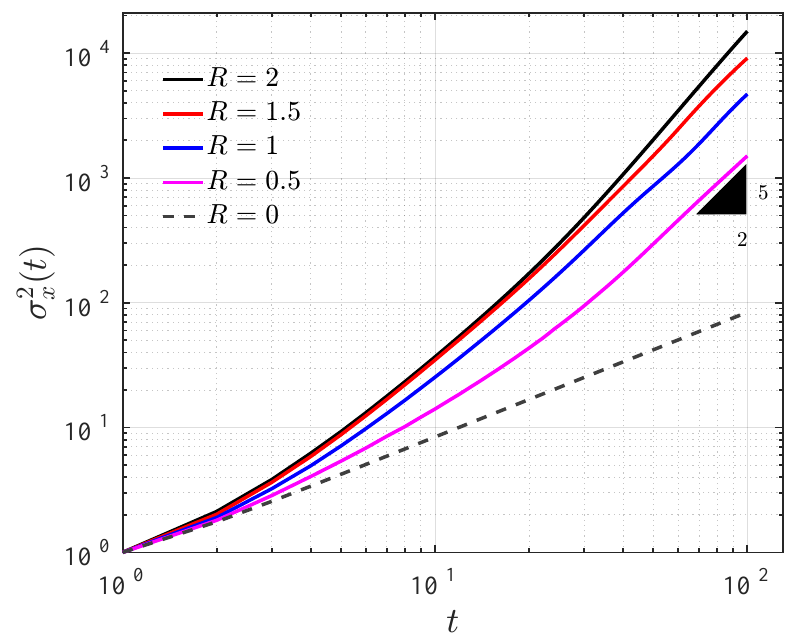
Figure 5. Temporal evolution of the variance of transversely averaged concentration, σ 2 x ( t ) .